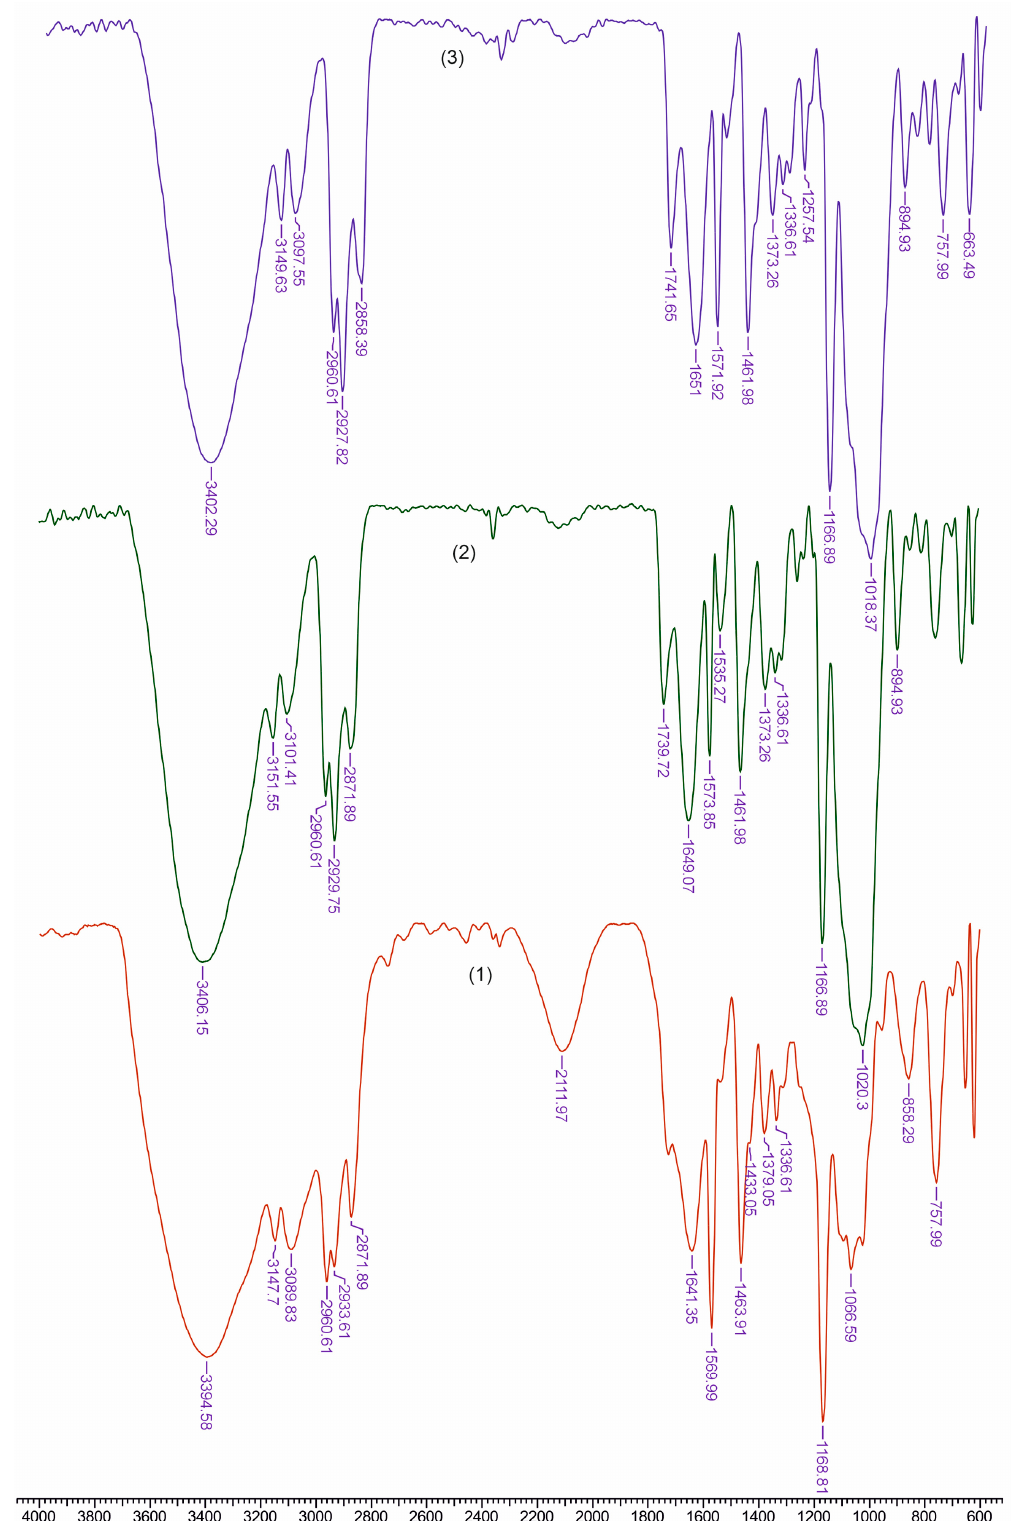
Figure 3. FTIR spectra of the obtained biomaterials: ( 1 )—cellulose–collagen–polyurethane; ( 2 )—TAN; ( 3 )—LIP .